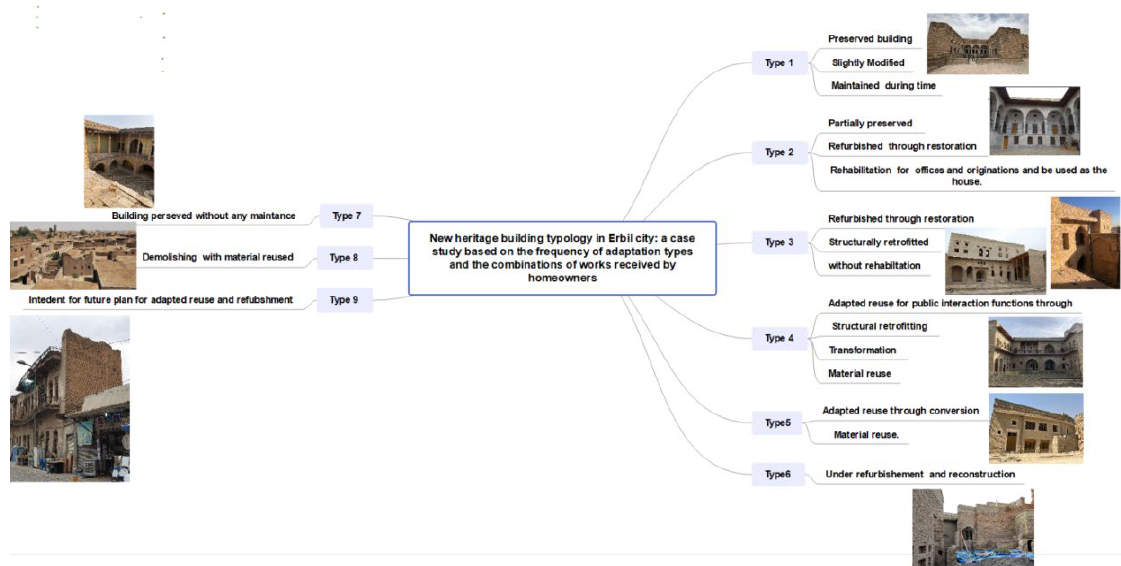
Figure 17. Prototype developed by heritage building adaptation applications in Erbil City.